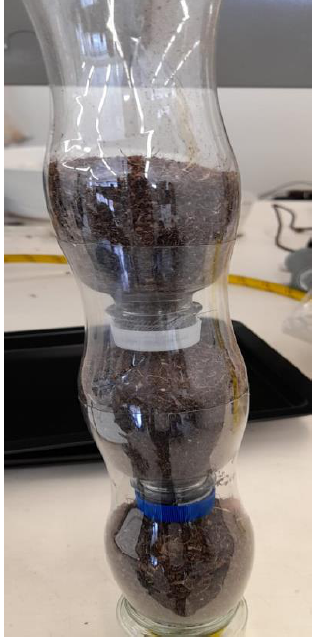
Figure 1. Treatment system configuration.